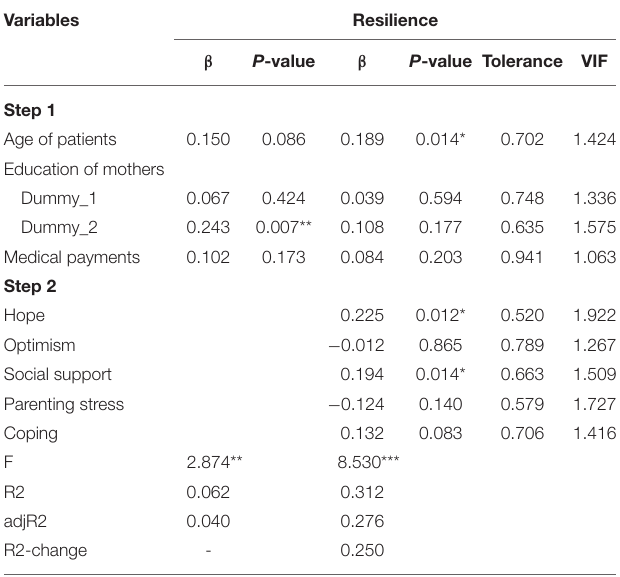
TABLE 5 | Hierarchical linear regression analysis on results of resilience among fathers of patients with CL/P ( n = 69). Variables